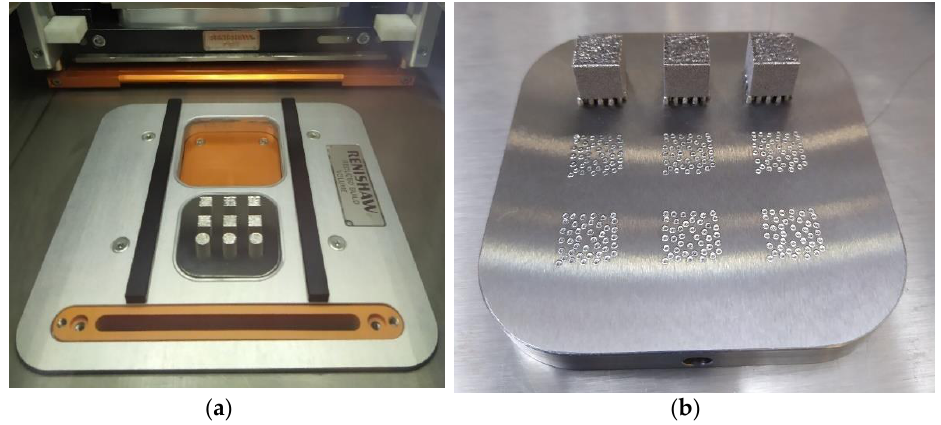
Figure 3. SLMed Inconel 718 cubes in ( a ) the build chamber after construction and ( b ) build plate on the fabrication of another set of experimental probes. Good surface finish is observed.